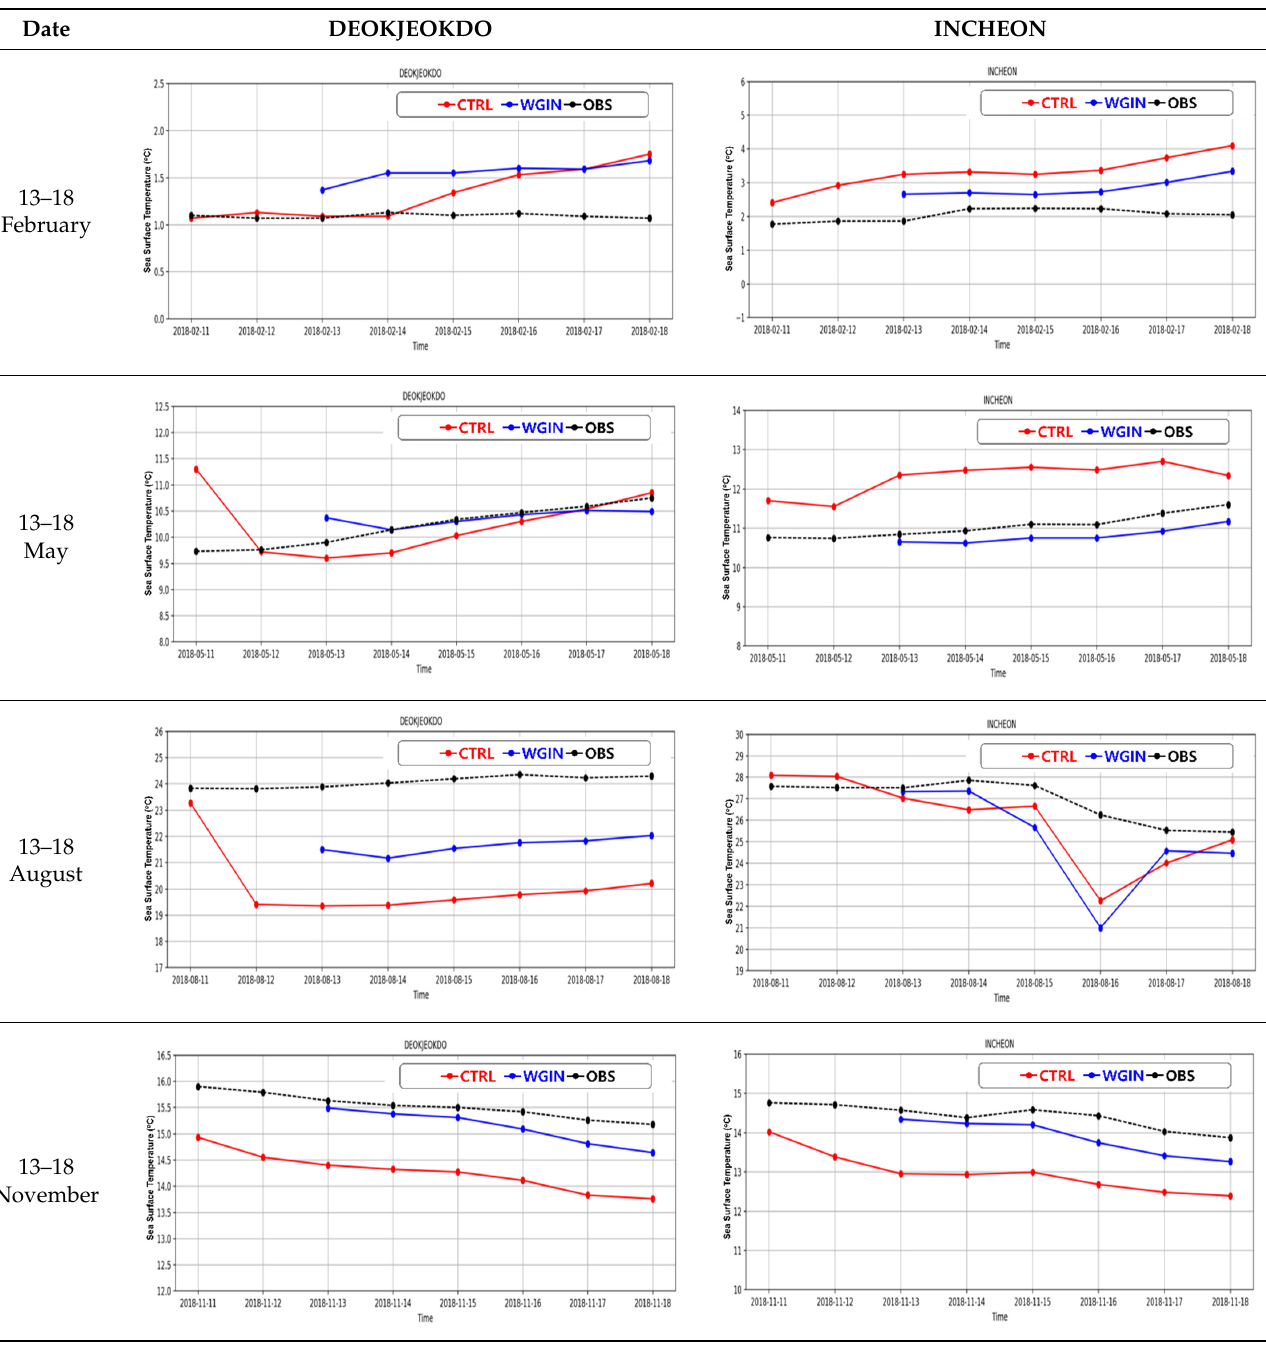
Table 4. Time series comparison of CTRL (red), the WGIN (blue), and observations (black) at the Deokjeokdo (left) and Incheon (right) buoy stations, respectively. The top, second from the top, second from the bottom, and bottom figures indicate February, May, August and November, respectively.